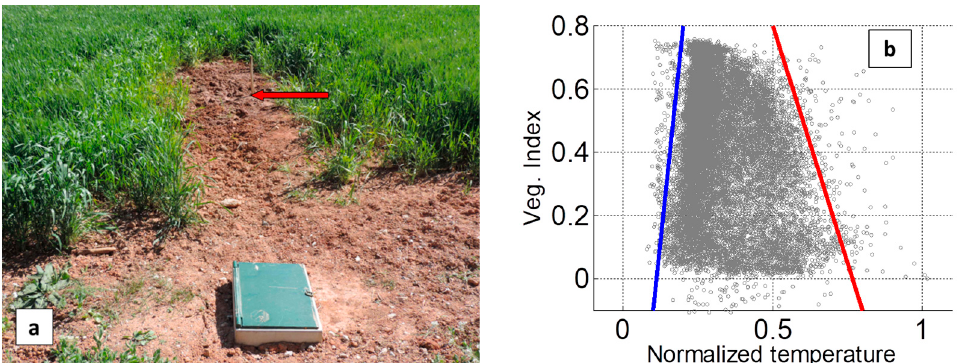
Figure 7. ( a ) Picture (directed southward) of the Le Tholonet test site (spring ‐ wheat field) where an artificial leak was introduced. To the main pipe running east–west, an additional pipe was connected (see the connection box) in the south direction. The added pipe had a 10 mm hole, 5 m south of the connection (as indicated by the stick and the arrow in the gap downhill). ( b ) 2D scatterplot of temperature and vegetation index as obtained during a flight on 21 April 2017.